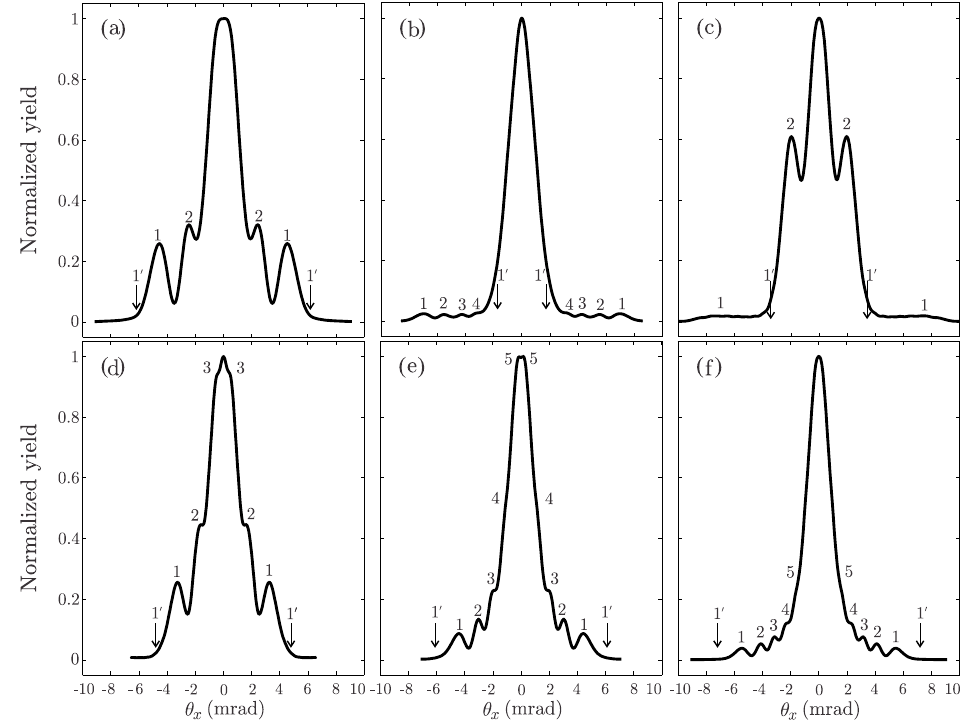
Figure 9. Angular distributions along θ x axis for 1-MeV positrons transmitted through 200-nm long SWCNT: ( a ) (7, 3); ( b ) (8, 5); ( c ) (9, 7); ( d ) (14, 4); ( e ) (16, 5); and ( f ) (17, 7). Arrows show positions of maxima in the corresponding classical angular distributions. Symmetrical maxima are designated by the same